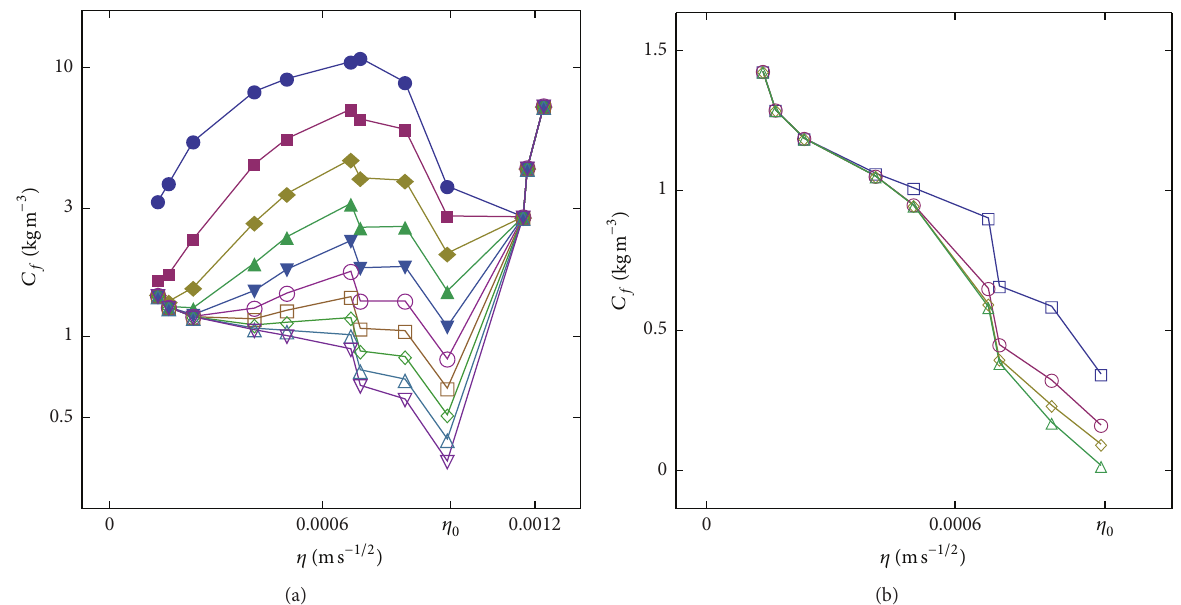
Figure 3: (a) The profile of the free chloride concentration obtained from the experimental data for 𝜂 𝜏 = 0.1𝜂 0 , 0.2𝜂 0 ,...,𝜂 0 (from top to bottom). (b) The profile of the free chloride concentration in the interval 𝜂 ≤ 𝜂 0 for 𝜂 𝜏 = 𝜂 0 , 1.5𝜂 0 , 2𝜂 0 , 5𝜂 0 (from top to